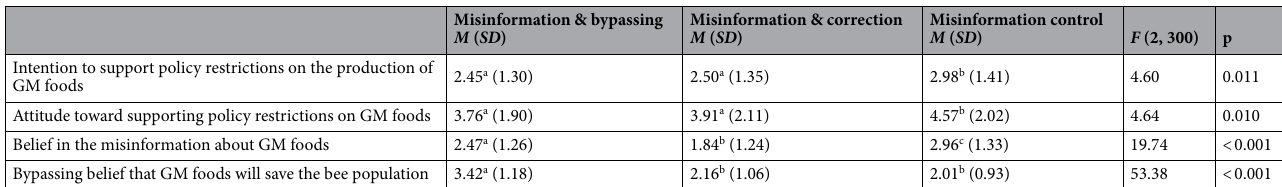
Table 2. Experiment 2 results (N = 303). Different superscripts indicate statistically significant pairwise contrasts.